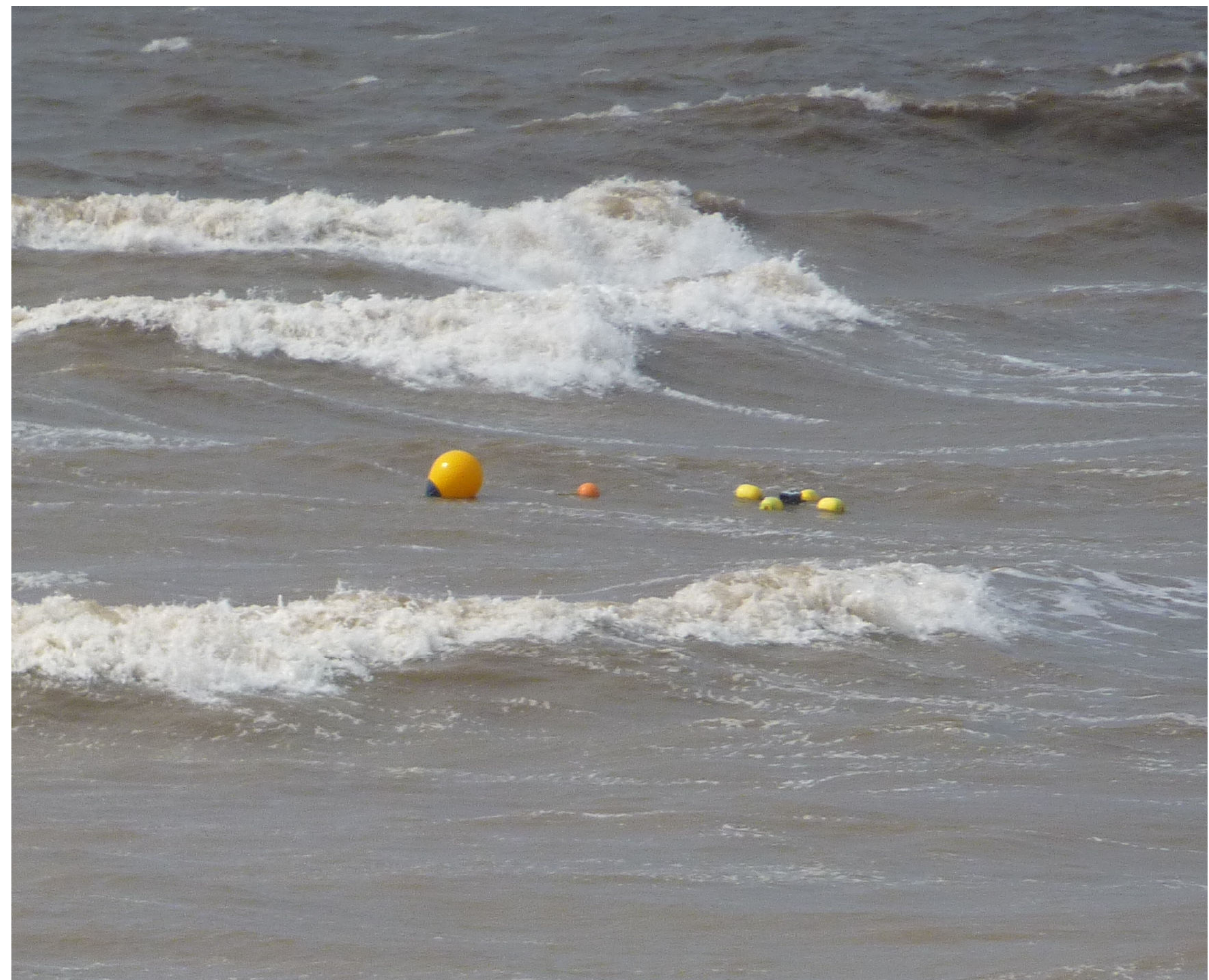
Figure 9. GNSS buoy at 13:24 on 29 August, prior to recovery; spilling waves can be seen in the background.